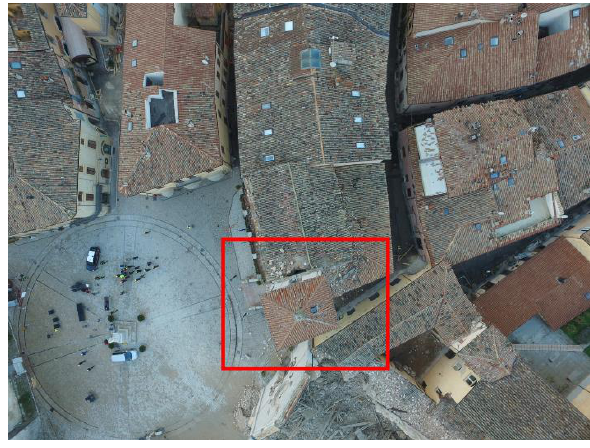
Figure 8. Image to build the orthophoto. The red rectangle frames the portion depicted in the orthophoto.